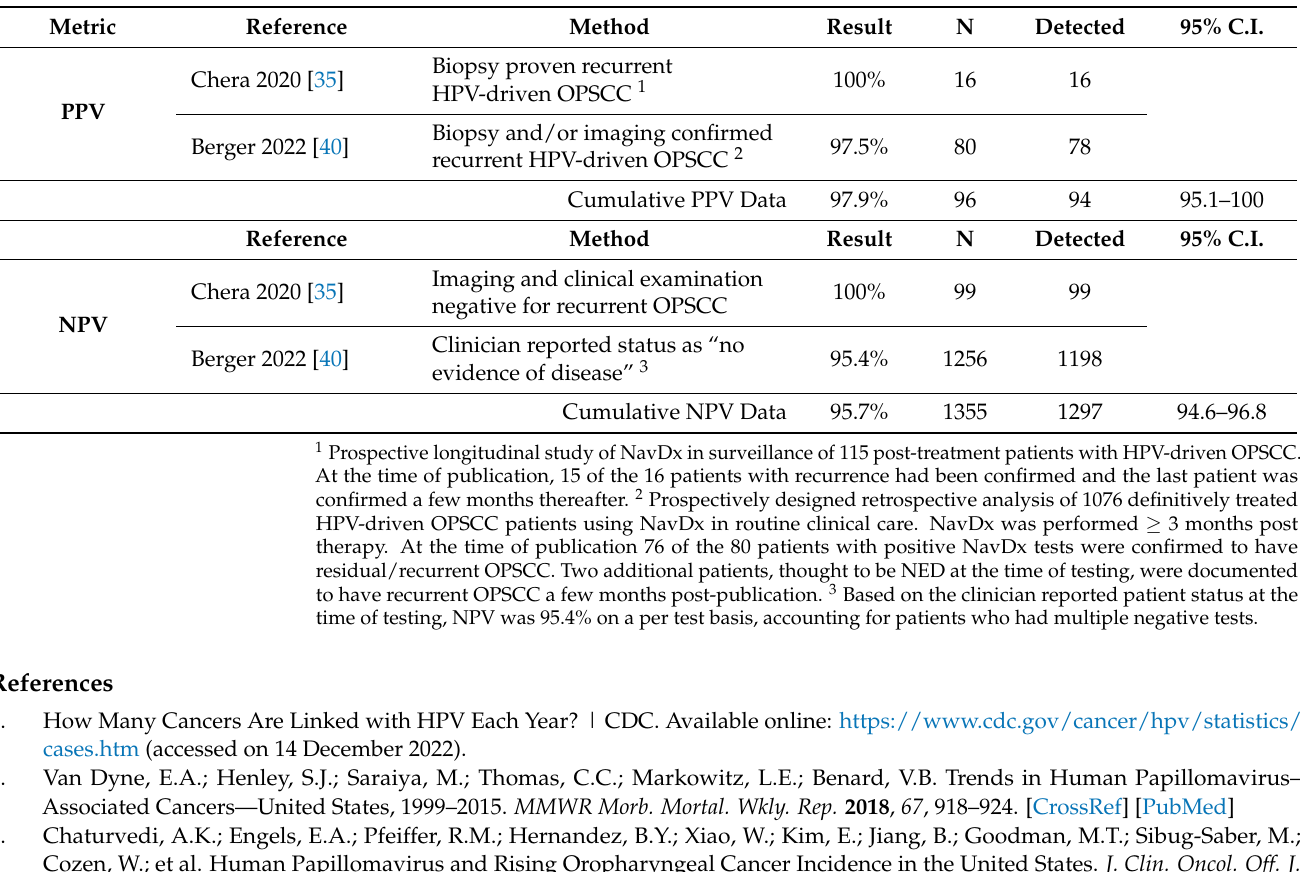
Table A3. NavDx Positive and Negative Predictive Value for the Detection of Patients with Residual and/or Recurrent HPV-Driven OPSCC in the Post-Treatment Surveillance